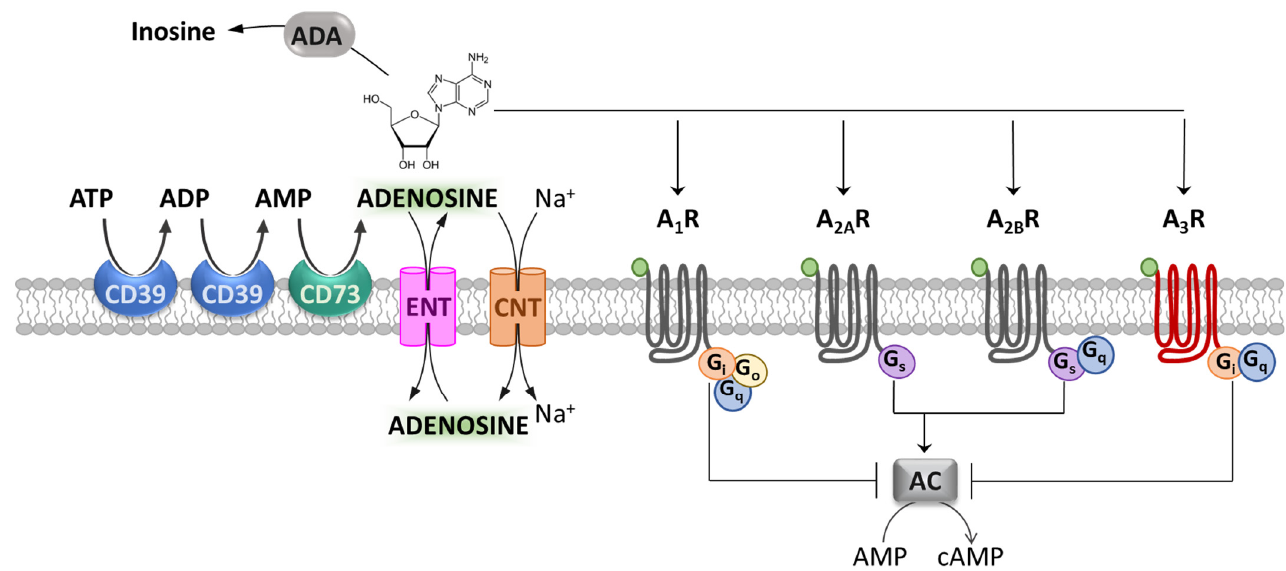
Figure 1. Adenosine and its receptors. Schematic representation of adenosine metabolism, transport and metabotropic receptors. The ectonucleotidases CD39 and CD73 metabolize ATP and ADP to AMP, and AMP to adenosine. The equilibrative nucleoside transporter (ENT) or concentrative nucleoside transporter (CNT) families mediate adenosine reuptake. Adenosine metabotropic receptors (A 1 , A 2A , A 2B and A 3 receptors: A 1 R, A 2A R, A 2B R and A 3 R) are differently coupled to adenylyl cyclase (AC) inhibition or stimulation. Adenosine deaminase (ADA) deactivates extracellular adenosine by converting it into